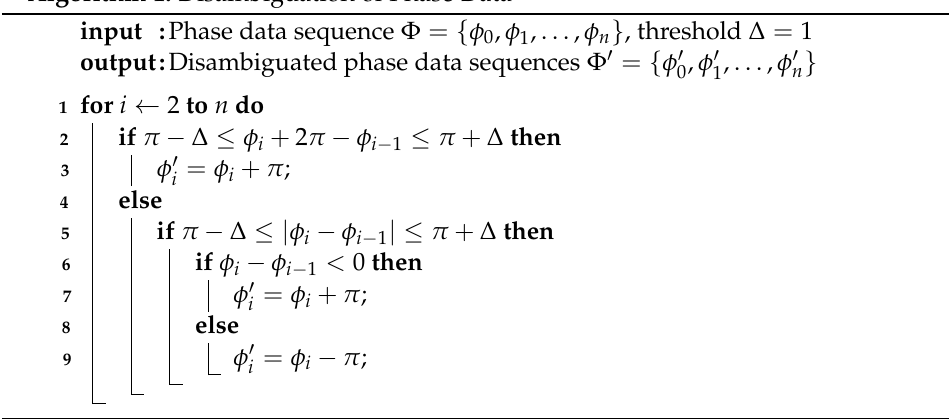
Algorithm 1: Disambiguation of Phase